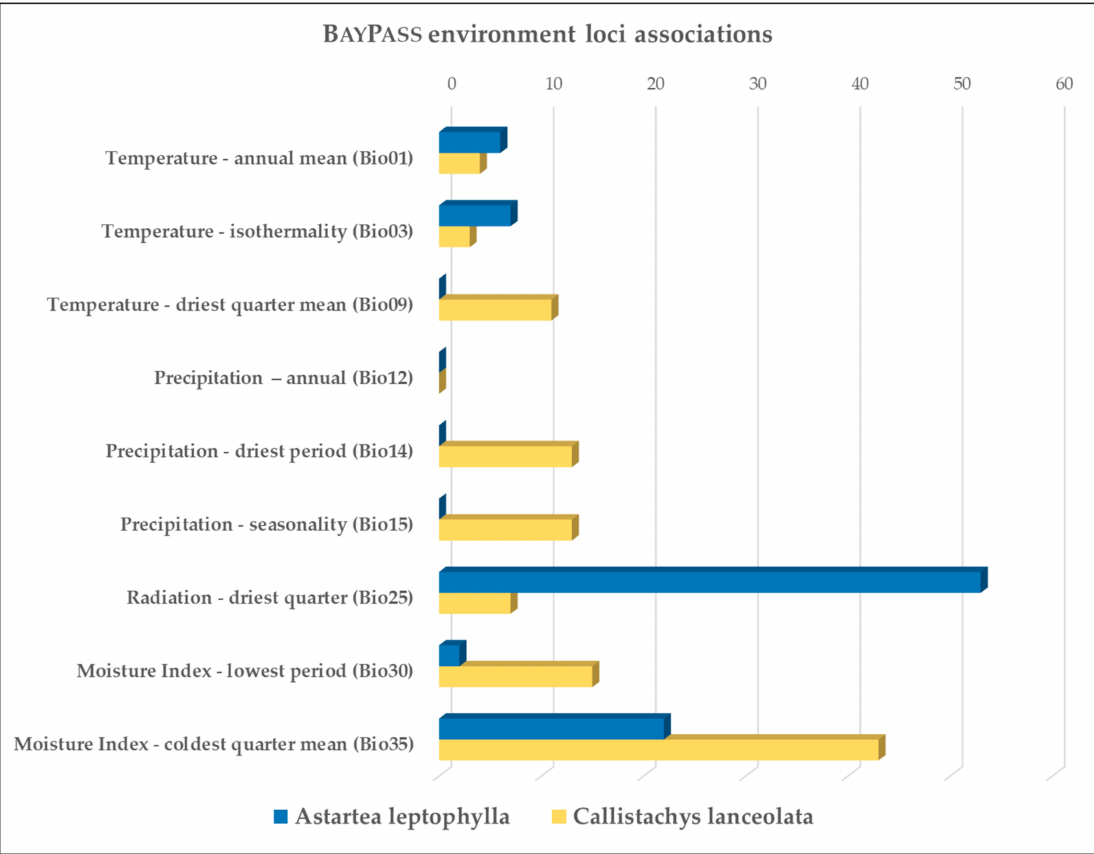
Figure 5. The number of environmental loci associations detected in B ay P ass for Astartea leptophylla and Callistachys lanceolata for each environmental